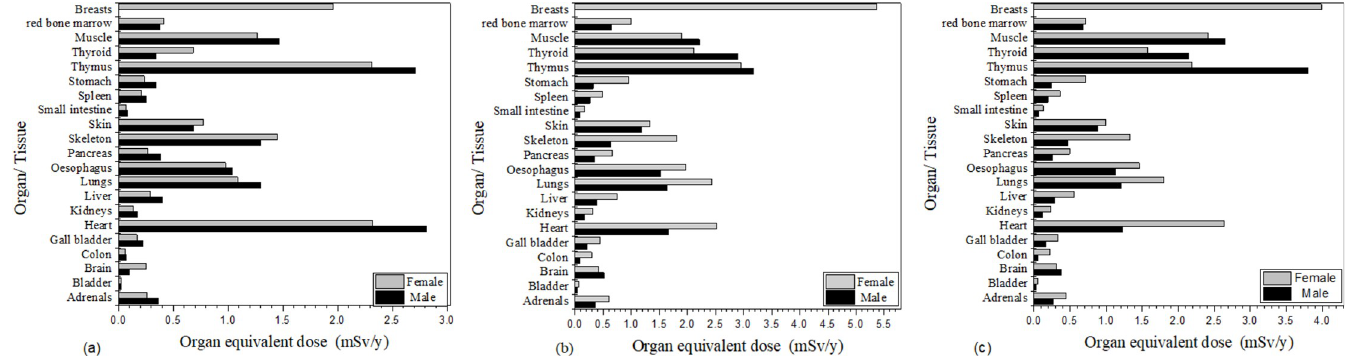
Fig 6. Organ equivalent dose (mSv/y) for 21 organs using the MIRD5 mathematical male and female phantoms, for: (a) CP8; (b) GP11; (c) MP15.